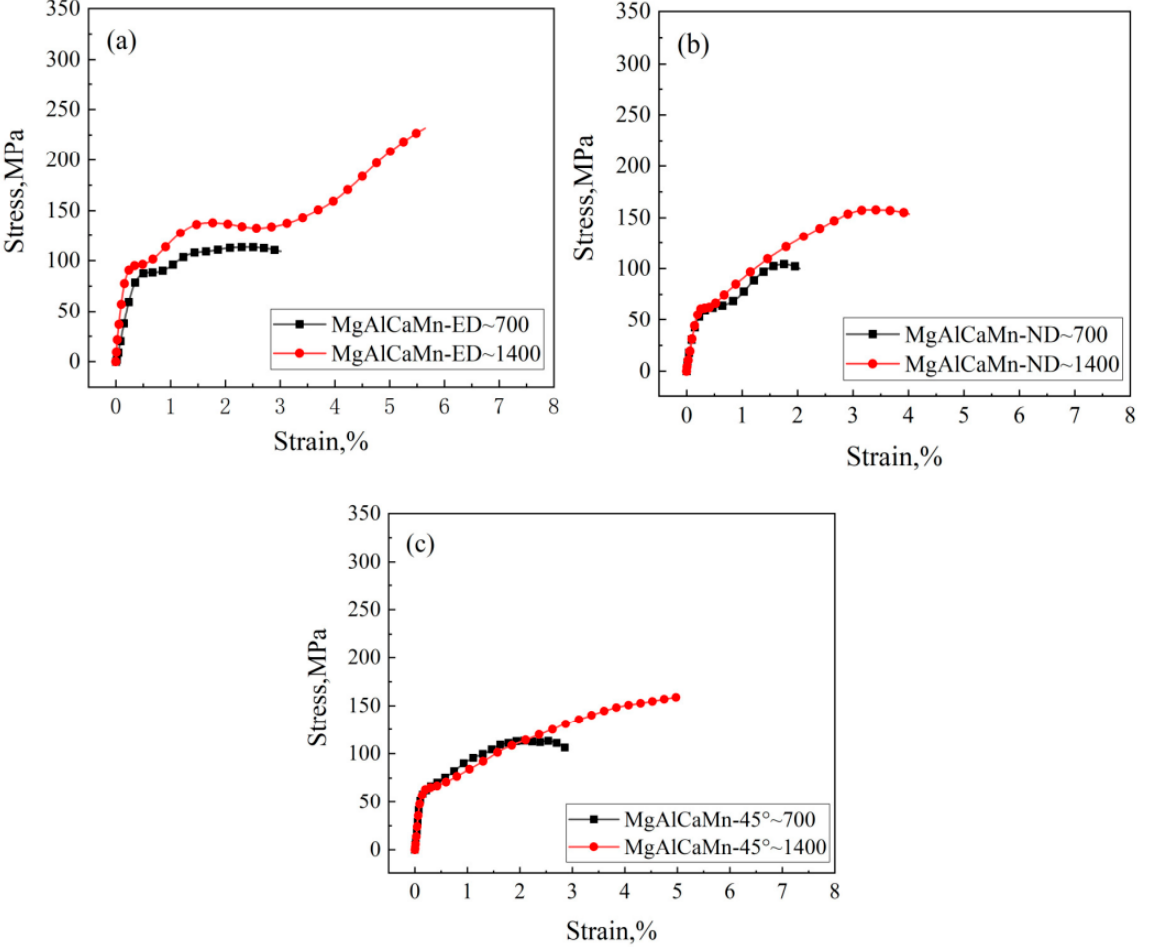
Figure 5. Stress–strain curves of Mg-Al-Ca-Mn alloy under high strain rate compression in the ( a ) ED direction, ( b ) ND direction, and ( c ) Horizontal 45°. Table 2. Mechanical properties of Mg-Al-Ca-Mn alloy under high strain rate compression in different directions. Directions